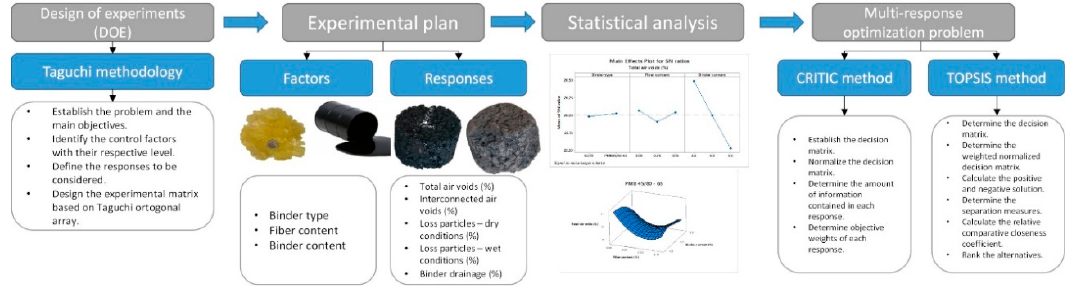
Figure 3. Structured framework proposed for the multi-objective optimization.